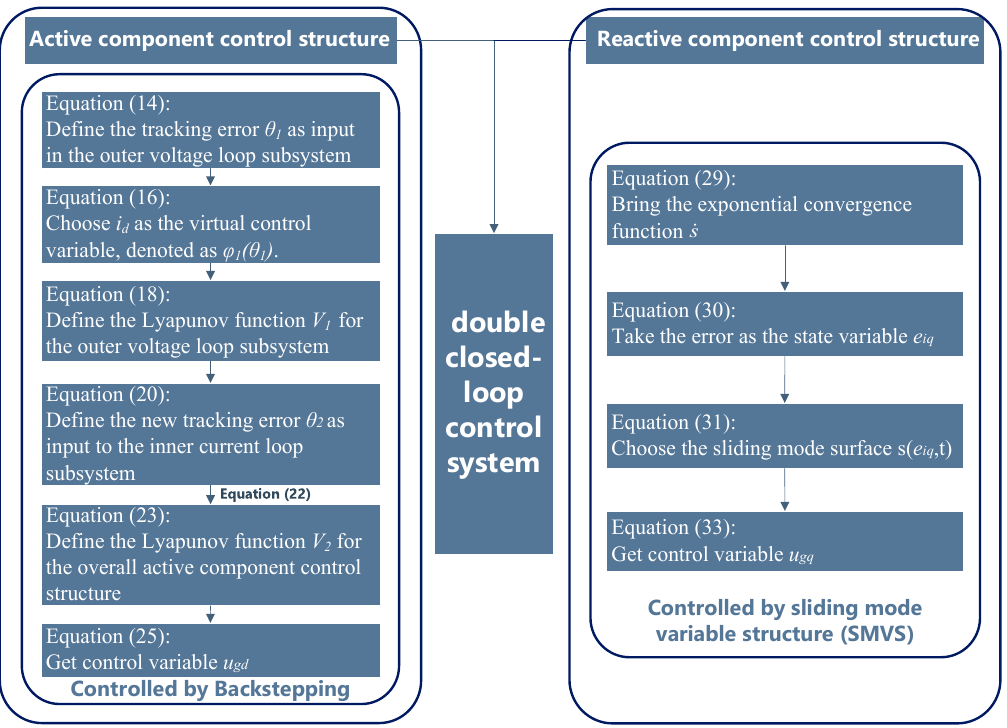
Figure 1. Outline of double closed-loop control system.